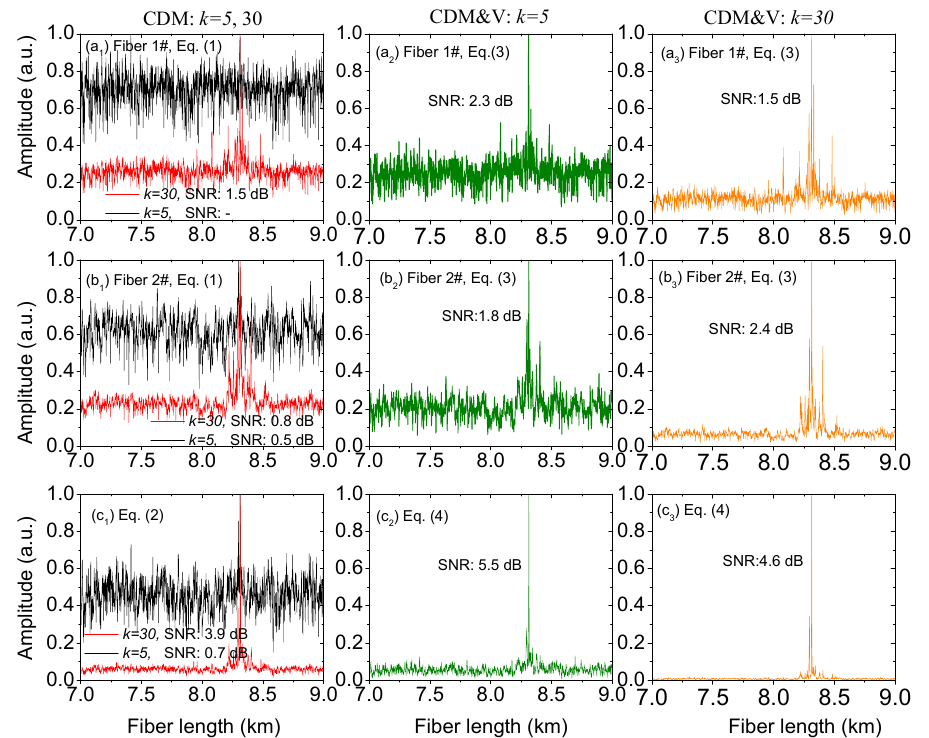
Figure 5. Vibration signals at 8.3 km for different differential steps (i.e., k). The first and second rows respective denote the accumulated differential signal in fiber 1# and in fiber 2#, and the third row is the synthesized signals combining fiber 1# and fiber 2#. The first column is computed by the CDM, and the second and third are by the CDM&V. In the experiment, 100 consecutive Rayleigh traces are measured for each sensing fiber (N = 100).